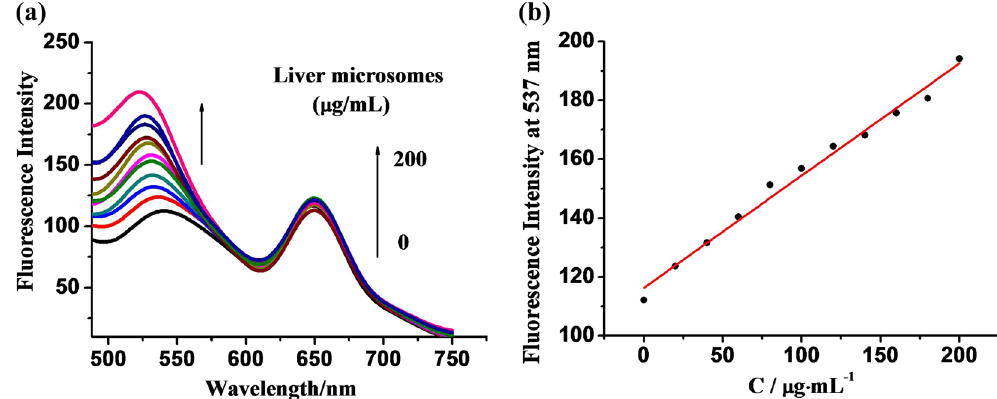
Figure 3. ( a ) Fluorescence emission titration spectra of probe (1) (3.0 × 10 − 5 M) in the presence of varying concentrations of rat liver microsome (0~200 ug/mL) in PBS (0.01 M, pH = 7.4)with 1% DMSO and 80 µ M NADH. ( b ) Correlation between emission intensities at 537 nm and concentrations of liver microsome.